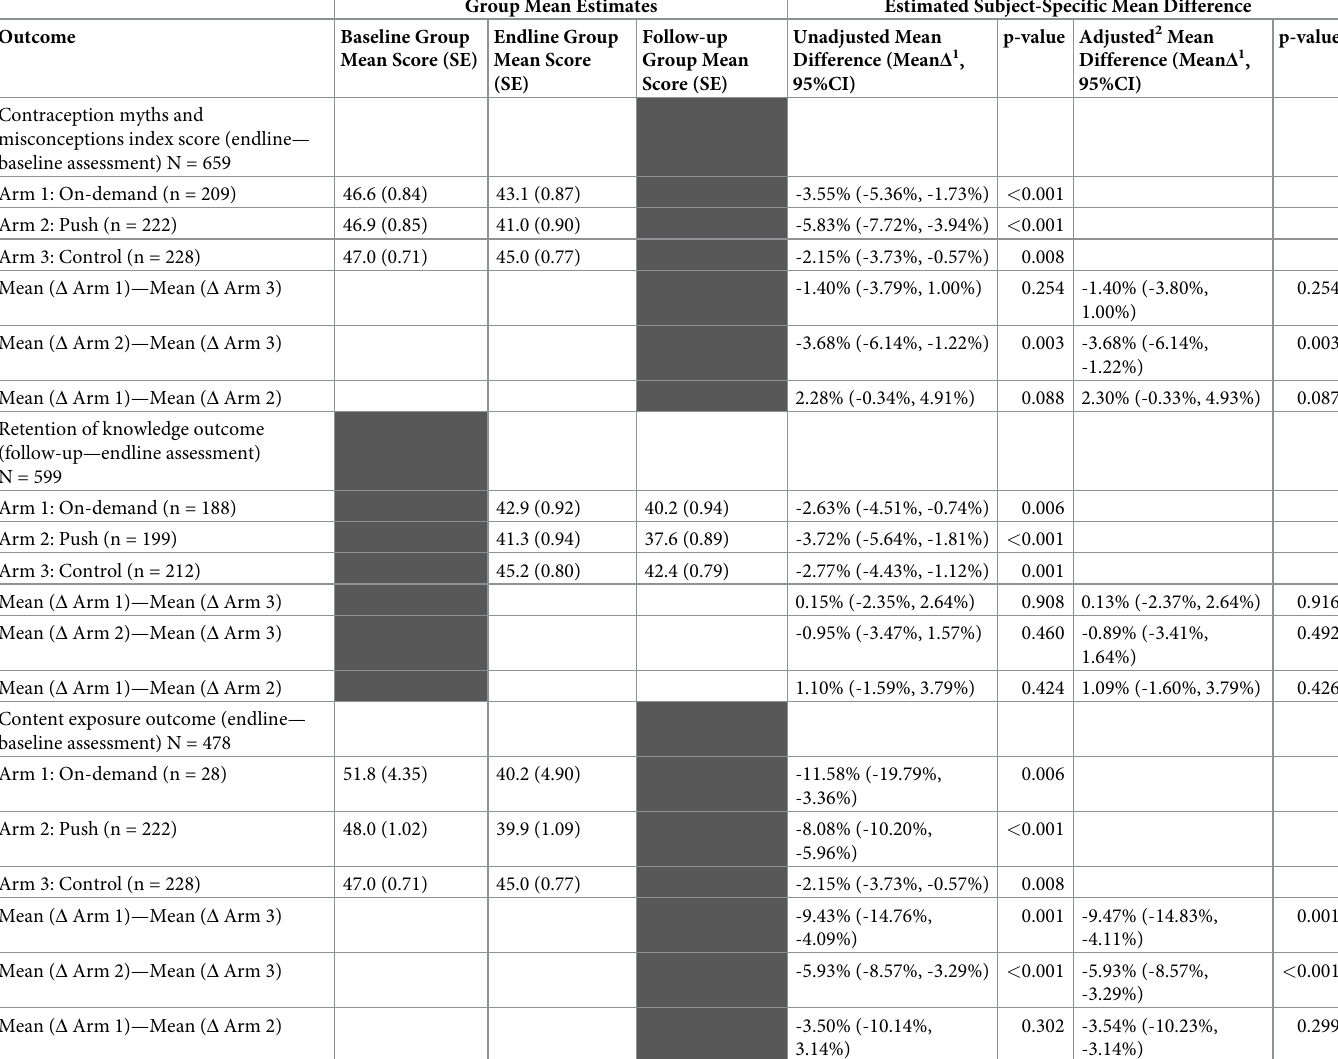
Table 2. Analysis of primary and secondary outcomes comparing difference in scores between intervention arms and survey time period among female and male 13–17 year olds, San Juan de Miraflores, Lima,